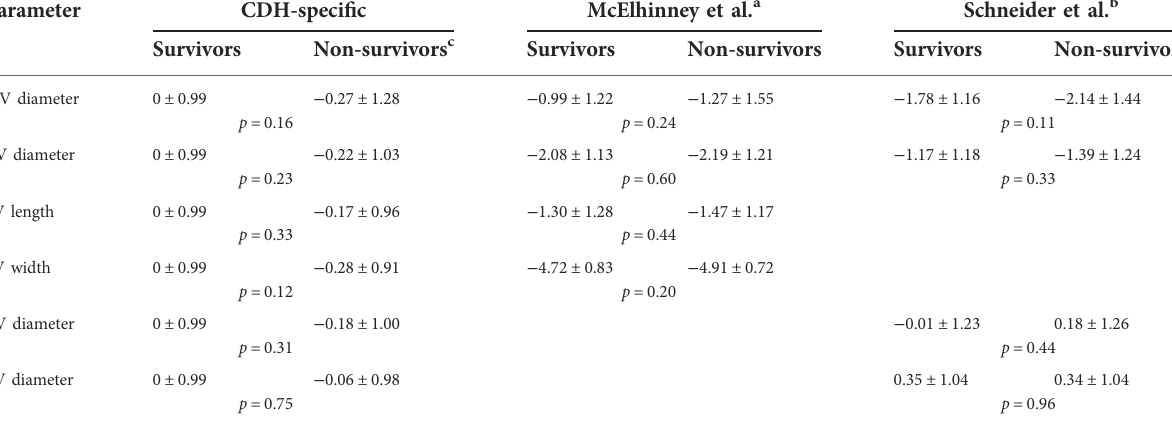
TABLE 4 Survival to discharge and z-scores for cardiac structures derived from equations from CDH-speci fi c and unaffected fetuses.